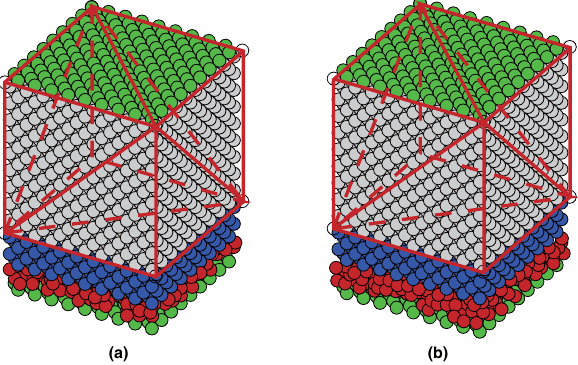
Fig. 10 Schematic diagram of three-dimensional (a) two-layer and (b) three-layer molecular thin-film lubrication system with periodic boundary conditions in the x - and y -directions. The wall, the elastic substrate, and the fluid atoms are represented by the green, blue, and red spheres, respectively. The coarse-grained far region of the substrate is represented by the gray